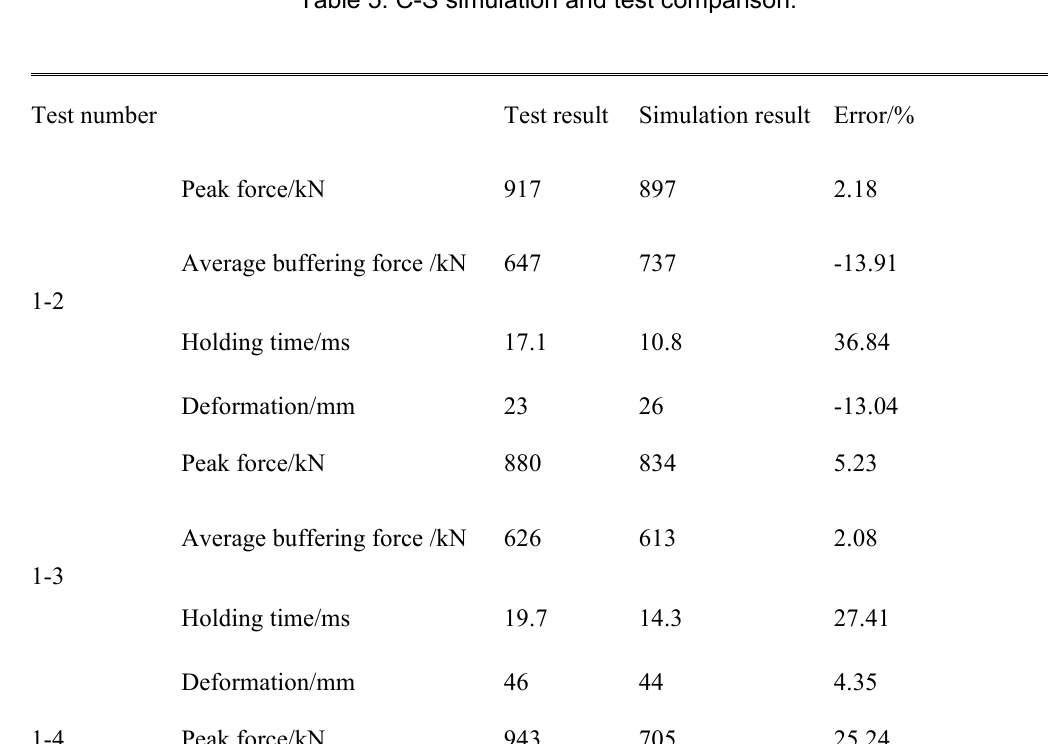
Table 5. C-S simulation and test